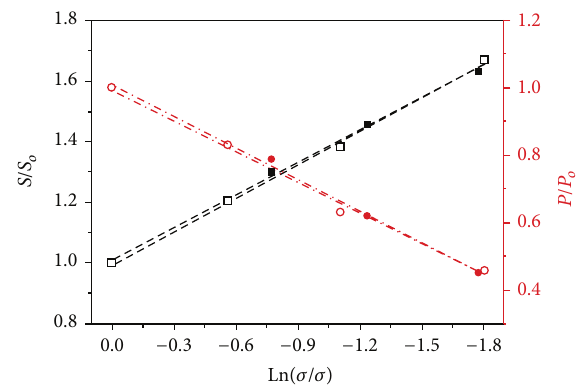
Figure 5: Thermoelectric properties of poly(3-hexylthiophene) P3HT-triflimide anion (TFSI) samples were filled and open symbols are samples that were kept inside and outside of desiccator, respec- tively